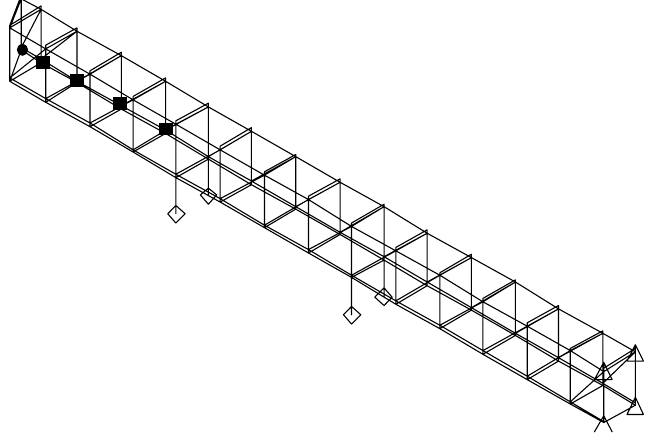
Fig. 1. Isometric View of Finite Element Model of the Bridge. Measurement points are indicated (cid:1) for forced vibration test. For studies of effects of stationary pedestrians, subjects stood as close as possible to point